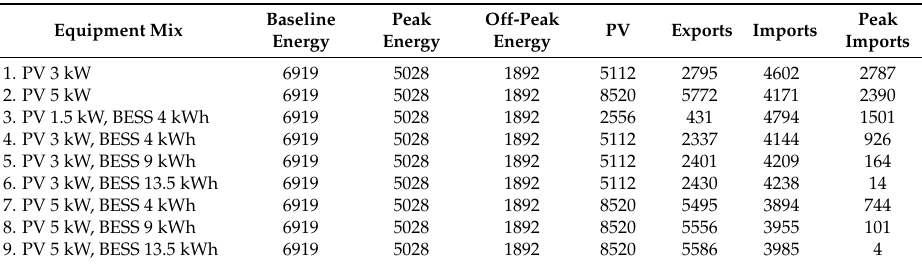
Table 7. Household energy profile results by equipment mix, in kWh.